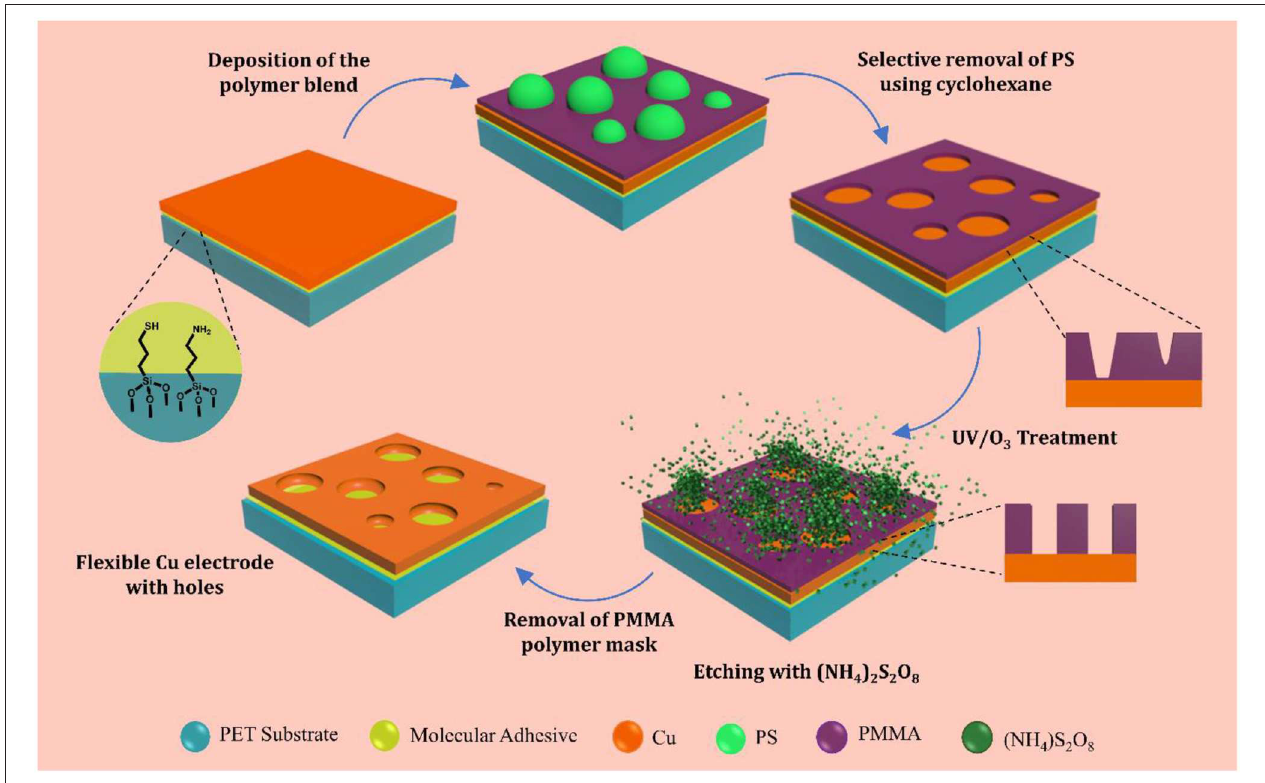
FIGURE 1 | Schematic of electrode fabrication